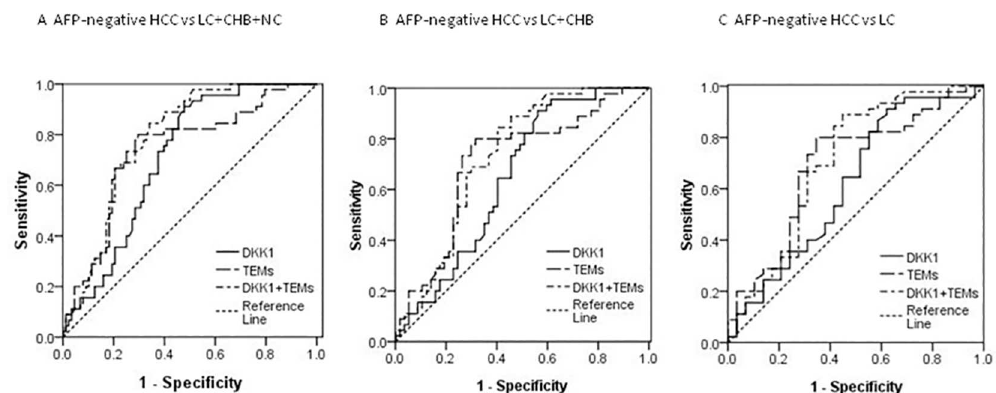
Fig 3. ROC curves for DKK1, TEMs and Logit P 2 for the diagnosis of AFP-negative HCC versus different cohorts. ( A) ROC curves for DKK1, TEMs and Logit P 2 for the diagnosisof HCC versus all controls, with an AUC value of 0.709, 0.739 and 0.785 respectively.(B) ROC curves for DKK1, TEMs and Logit P 2 for the diagnosisof HCC versus LC and CHB controls, with an AUC value of 0.649, 0.708 and 0.729 respectively.(C) ROC curves for DKK1, TEMs and Logit P 2for the diagnosis of HCC versus LC controls, with an AUC value of 0.620, 0.692 and 0.707 respectively. ROC = receiveroperatingcharacteristic. AUC = area under receiveroperatingcharacteristic. HCC = hepatocellular carcinoma.CHB = chronic hepatitis B virus infection. LC = liver cirrhosis. Logit P 2 = -2.565 +0.002 × DKK1+0.137 × TEMs.